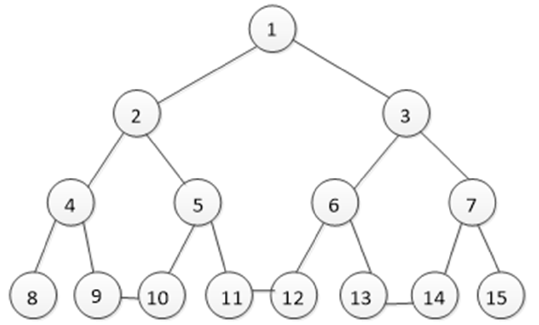
Figure 5. Network topology (Numbers 1–15 represent satellite nodes at different altitudes) (time T2).